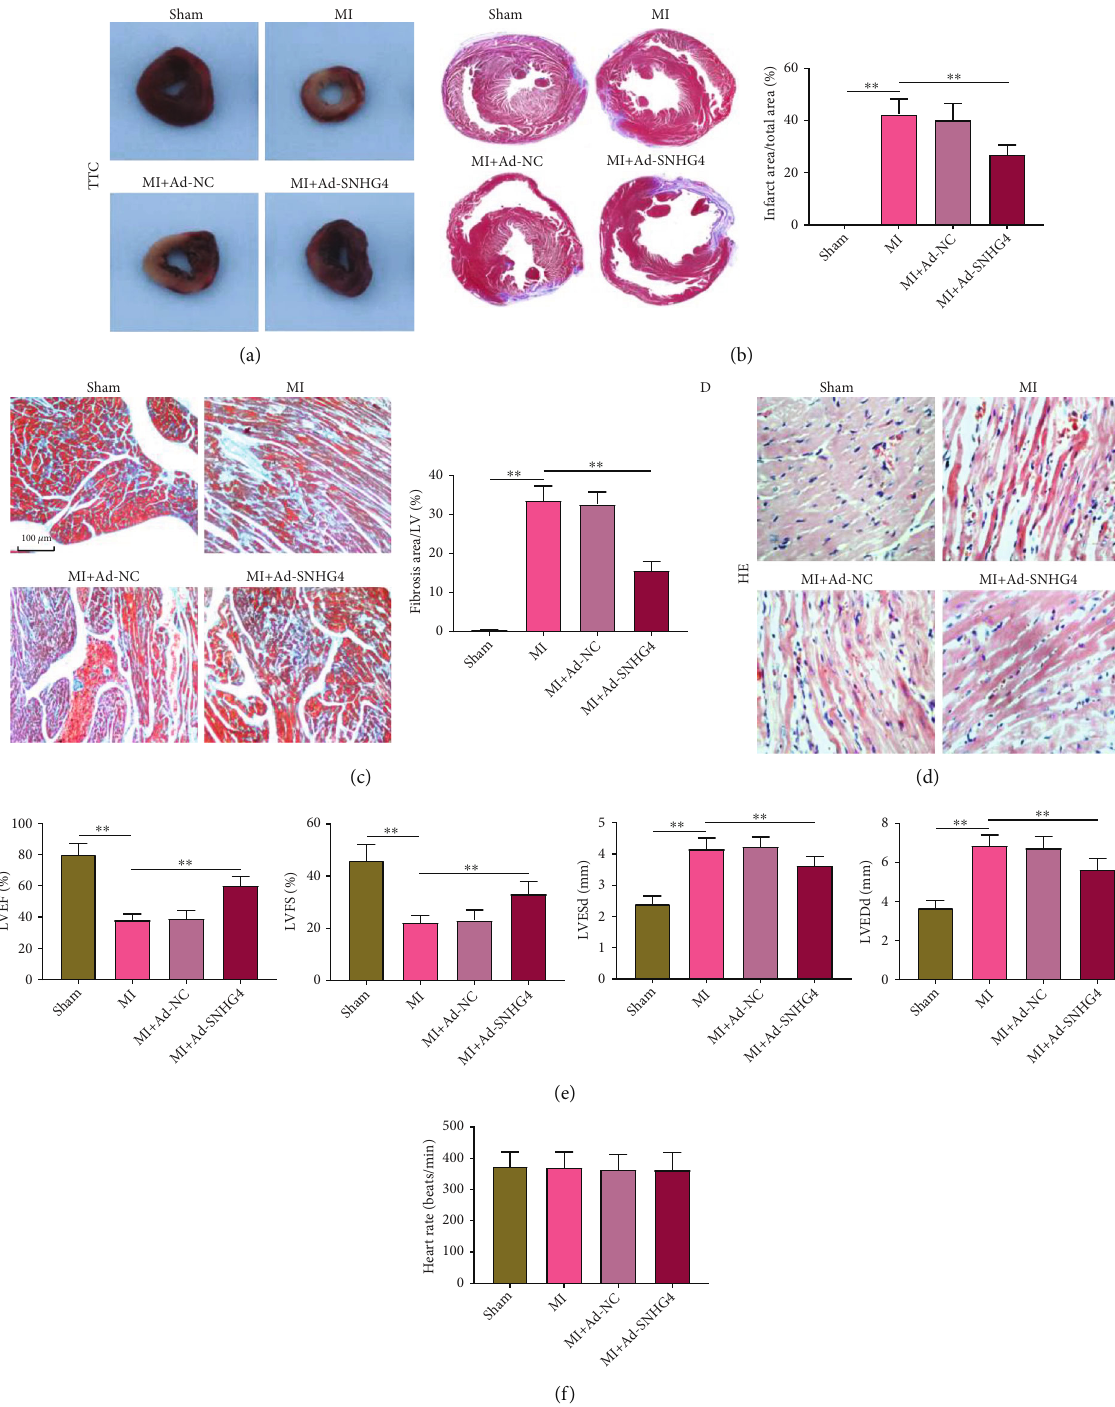
Figure 7: The e ff ects of SNHG4 overexpression on myocardial injury in MI rats. (a, b) The infarct area was observed by TTC staining ( × 200). (c) The fi brosis area was observed by MASSON ’ s staining ( × 200). (d) The pathological changes were observed by HE staining ( × 200). (e) The levels of LVEF, LVFS, LVESd, and LVEDd were measured by echocardiography. (f) The heart rate in rats. ∗∗ P < 0 : 01